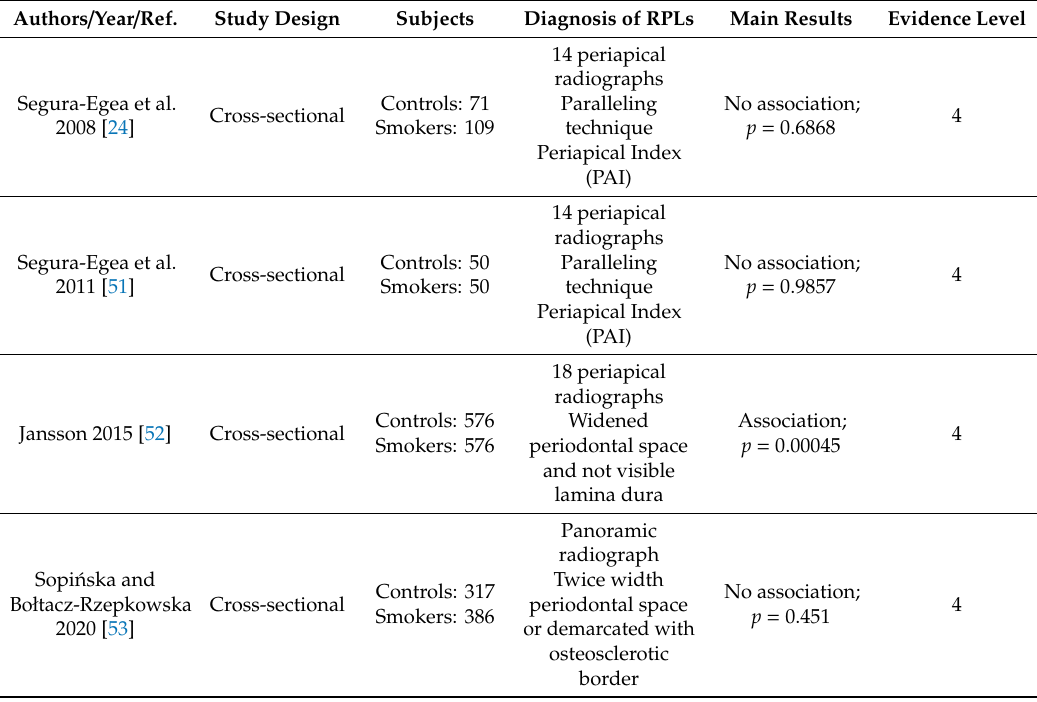
Table 2. Studies about smoking habits and the prevalence of root filled teeth (RFT) with radiolucent periapical lesions (RPLs) included in the systematic review. Study design, subjects and sample size, diagnosis of RPL, main results, and evidence level. Authors / Year /